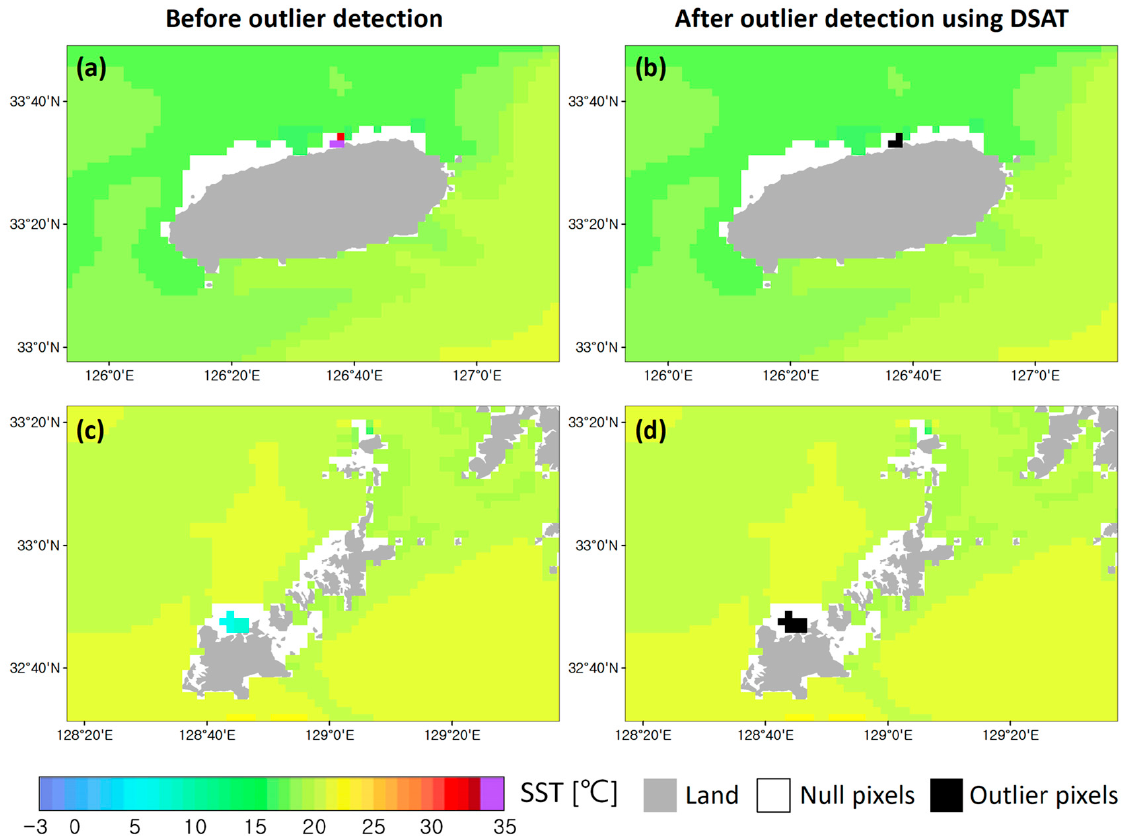
Figure 11. GK2A SST maps before and after outlier detection on 1 June 2020. ( a , b ): The mean SST of the three outlier pixels is 36.01 ◦ C, whereas the mean SST of the other pixels ( n = 322) is 17.18 ◦ C. ( c , d ): The mean SST of the eight outlier pixels is 6.72 ◦ C, whereas the mean SST of the other pixels ( n = 541) is 20.54 ◦ C.